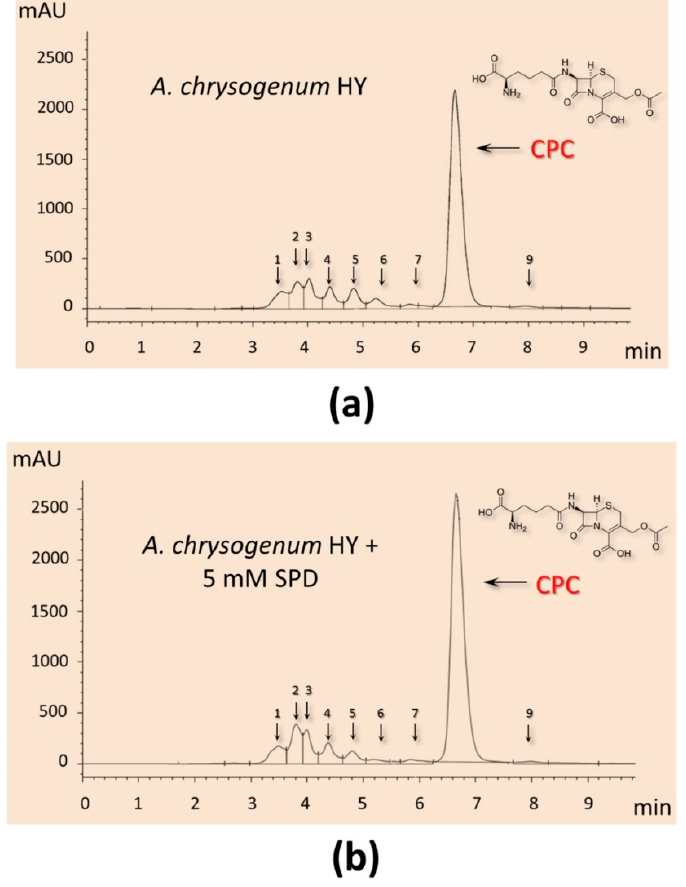
Figure 6. HPLC analysis of beta-lactam production of the A. chrysogenum high-yielding (HY) strain after 144 h of cultivation on complex (CP) medium: ( a ) cultivation without additives (control); ( b ) with 5 mM spermidine (SPD) added at the starting point of cultivation.